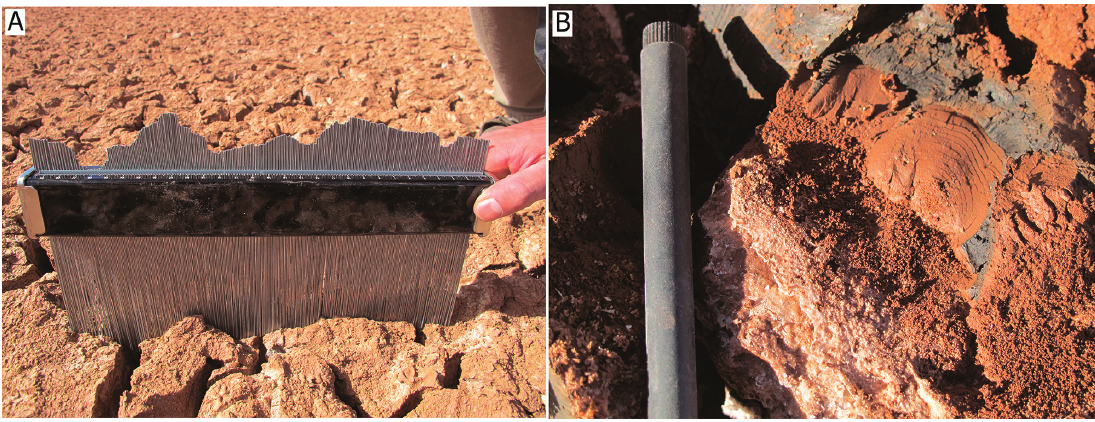
Figure 14. Clay-rich surface with high soil moisture ( A ) and abundance of desiccation cracks ( B